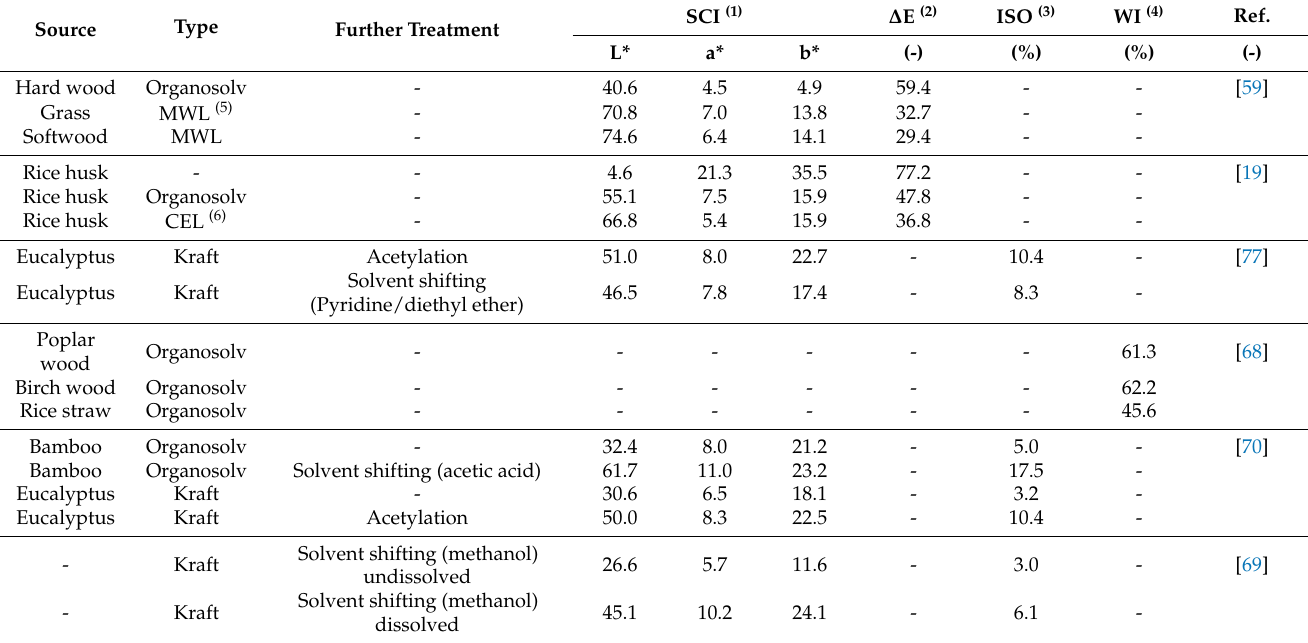
Table 3. Color properties of lignin depend on the source, type and treatment